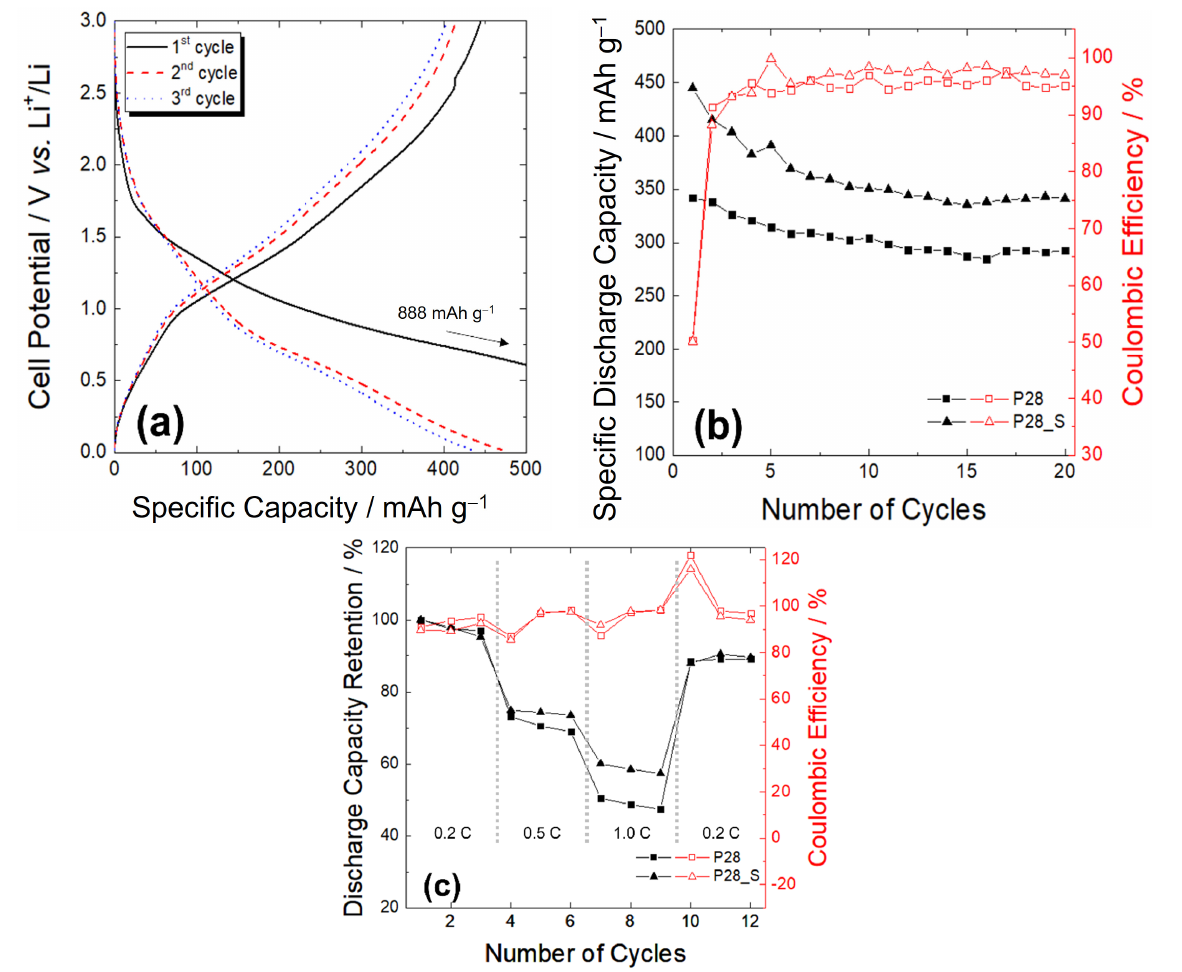
Figure 8. ( a ) Charge and discharge curves for the first three cycles at a rate of 0.2 C, obtained from the sample P28_S. ( b ) Variations in discharge capacity retention and coulombic efficiency with charge–discharge cycle at a rate of 0.2 C for samples P28 and P28_S. ( c ) Comparison of their rate capability.